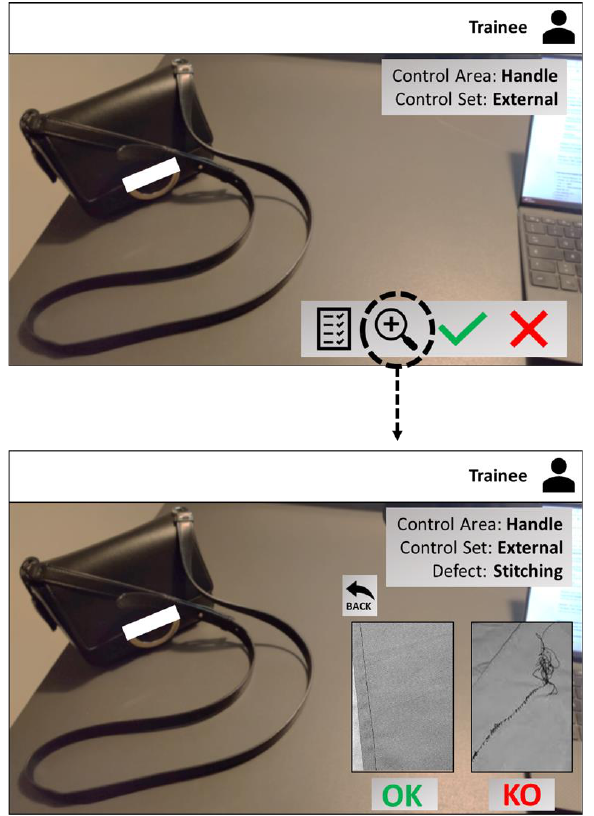
Figure 5. Trainee view per control area, control set, and defect (grey areas display the overlayed suggestions) .